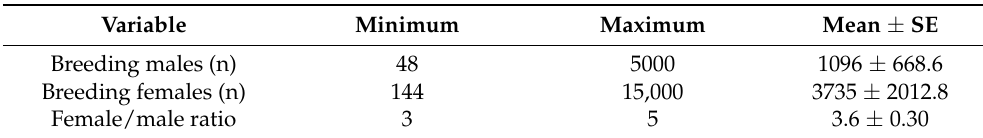
Table 2. Average size of breeding flock and the female/male ratio in complete-cycle quail game